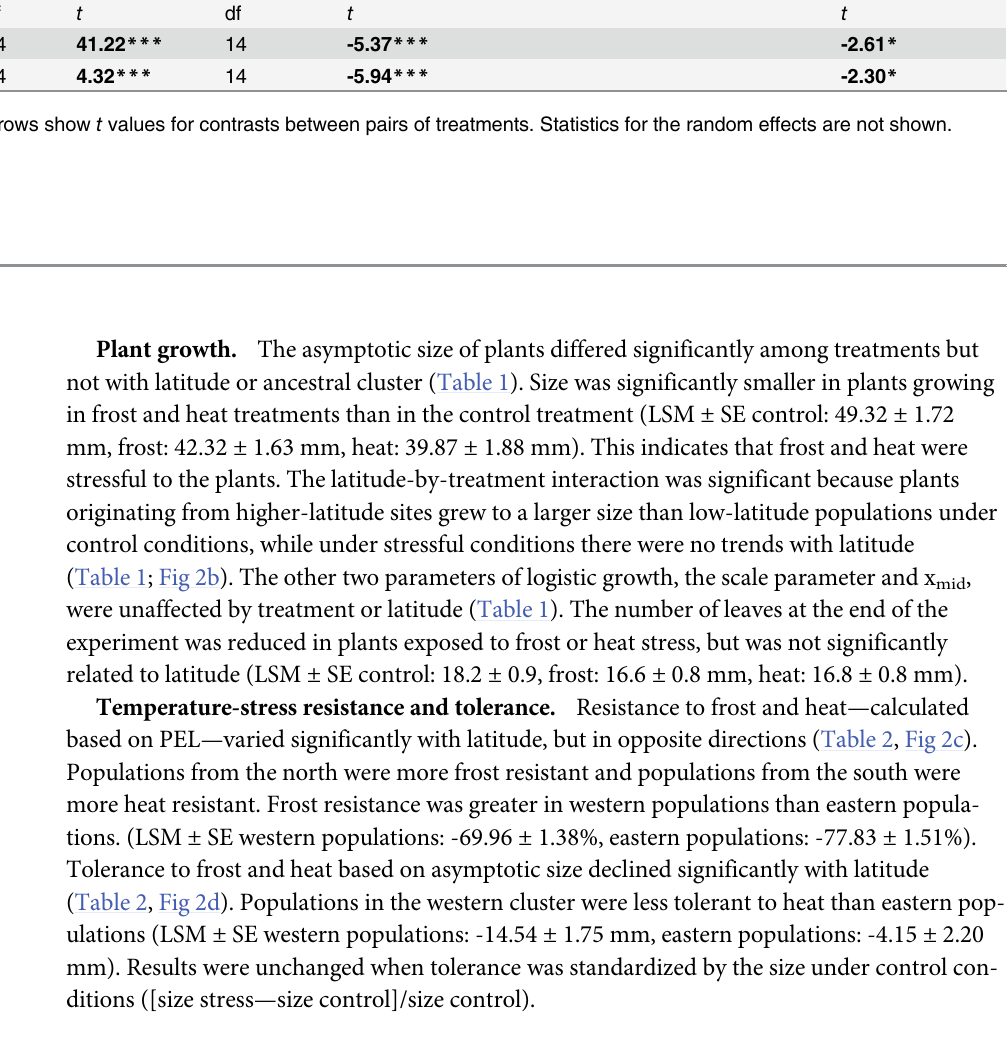
The table shows F values; the last two rows show t values for contrasts between pairs of treatments. Statistics for the random effects are not shown. Signi fi cance is indicated in bold: ( * ) P <